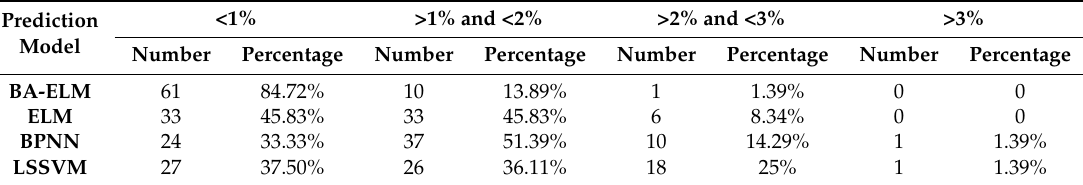
Table 10. Accuracy estimation of the prediction point for the test set.